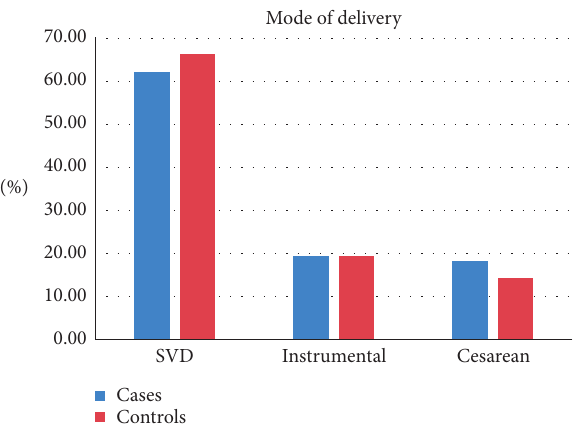
Figure 1: Mode of delivery among respondents delivering in public hospitals of South Gondar zone, Ethiopia, 2019 ( n � 140 cases and 280 controls). Table 3: Family planning-related characteristics of respondents delivering in selected public health hospitals of South Gondar zone, Ethiopia, 2019 ( n � 140 cases and 280